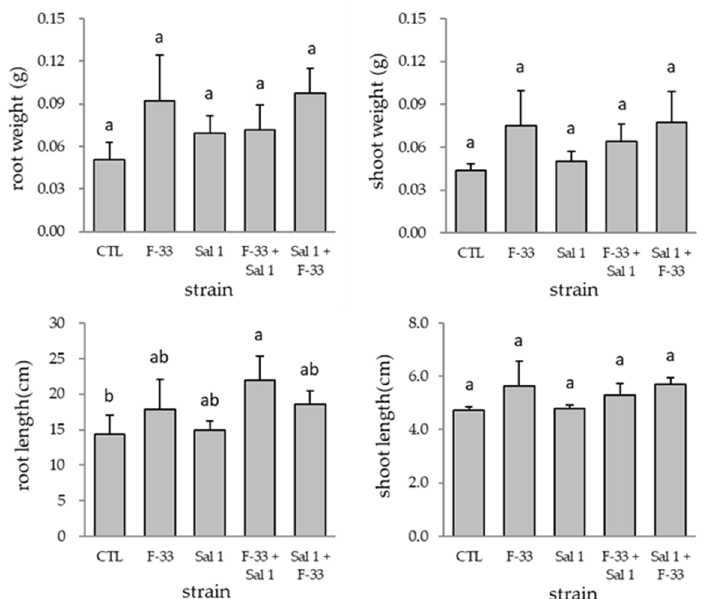
Figure 5. The effects of the time interval of inoculation on plant growth promotion and colonization of Bacillus sp. F-33 and Klebsiella sp. Sal 1 in the tomato plant. The tomato plant was cultivated using sterilized vermiculite, and the parameters were measured at 14 days after seed inoculation. In the time interval of inoculation, F-33 + Sal 1 and Sal 1 + F-33, the second inoculation was conducted 7 days after the first inoculation and analyzed 7 days after the second inoculation. CTL represents the control samples inoculated with autoclaved cultures. The bars represent the stand- ard deviation (n = 5), and different letters indicate significant differences at p < 0.05 by Tukey’s test.